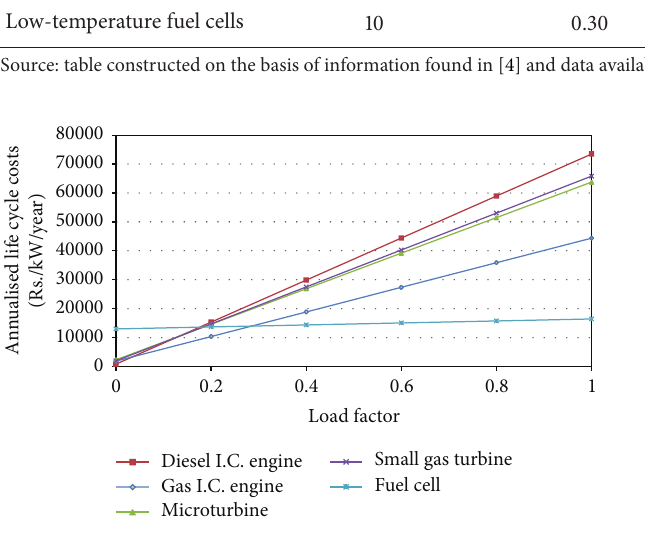
Figure 2: Comparison of annualised life cycle costs for different technological options, when only DG is considered (discount rate (𝑑) = 10 %) for the month of June 2011.